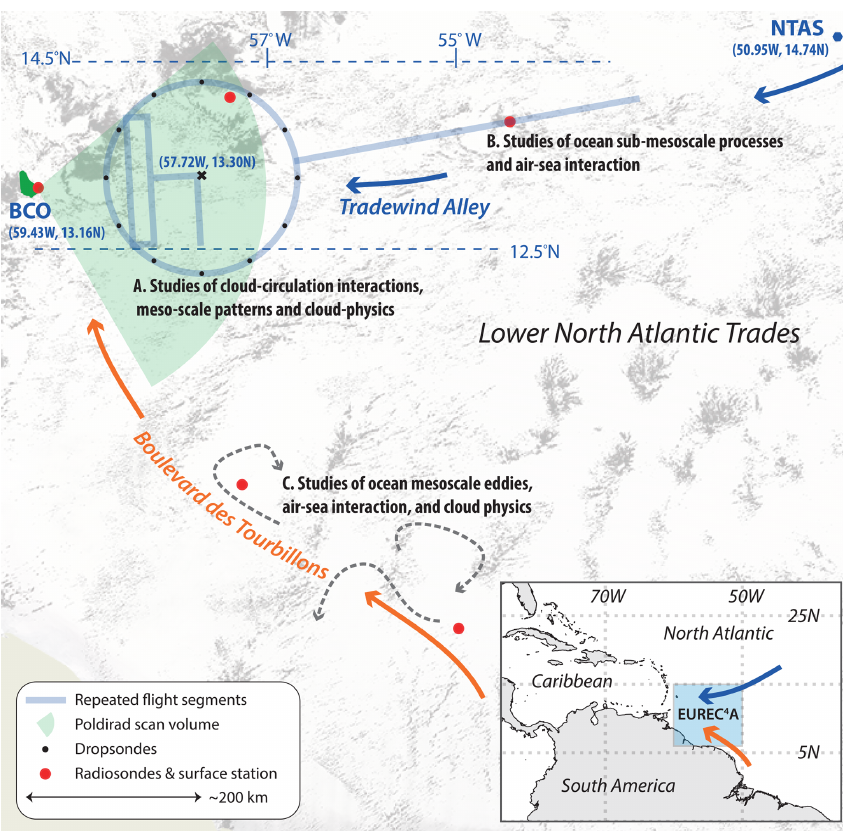
Figure 1. The EUREC 4 A study area in the lower trades of the North Atlantic. The zonally oriented band following the direction of the trades between the Northwest Tropical Atlantic Station (NTAS) and the Barbados Cloud Observatory (BCO) is called Tradewind Alley. It encompasses study areas A and B. The “EUREC 4 A-Circle” is defined by the circular airborne sounding array centered at 13.3 ◦ N, 57.7 ◦ W. A third study area (C) followed the southeast-to-northwest meanders of what we called the Boulevard des Tourbillons. The background shows a negative of the cloud field taken from the 5 February 2020 MODIS-Terra (ca. 14:30UTC)